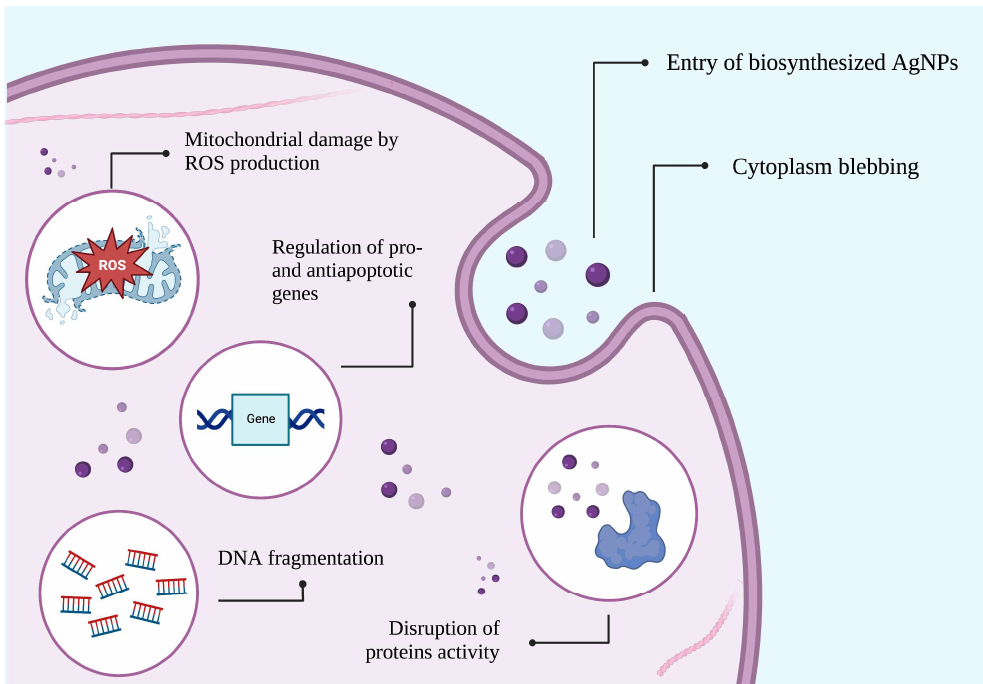
Figure 5. Possible anticancer mechanisms of biosynthesized AgNPs.